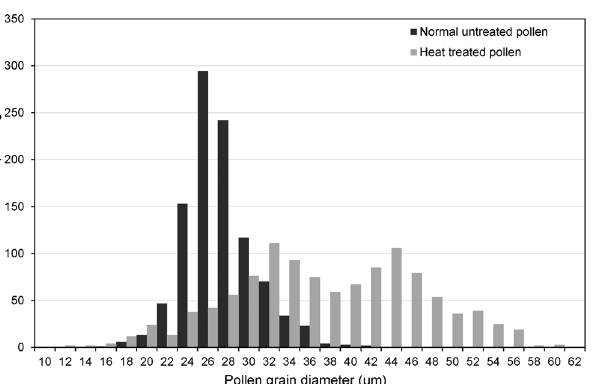
Figure 2. Frequency distributions of pollen grain diameters from the high temperature-treated buds and untreated control